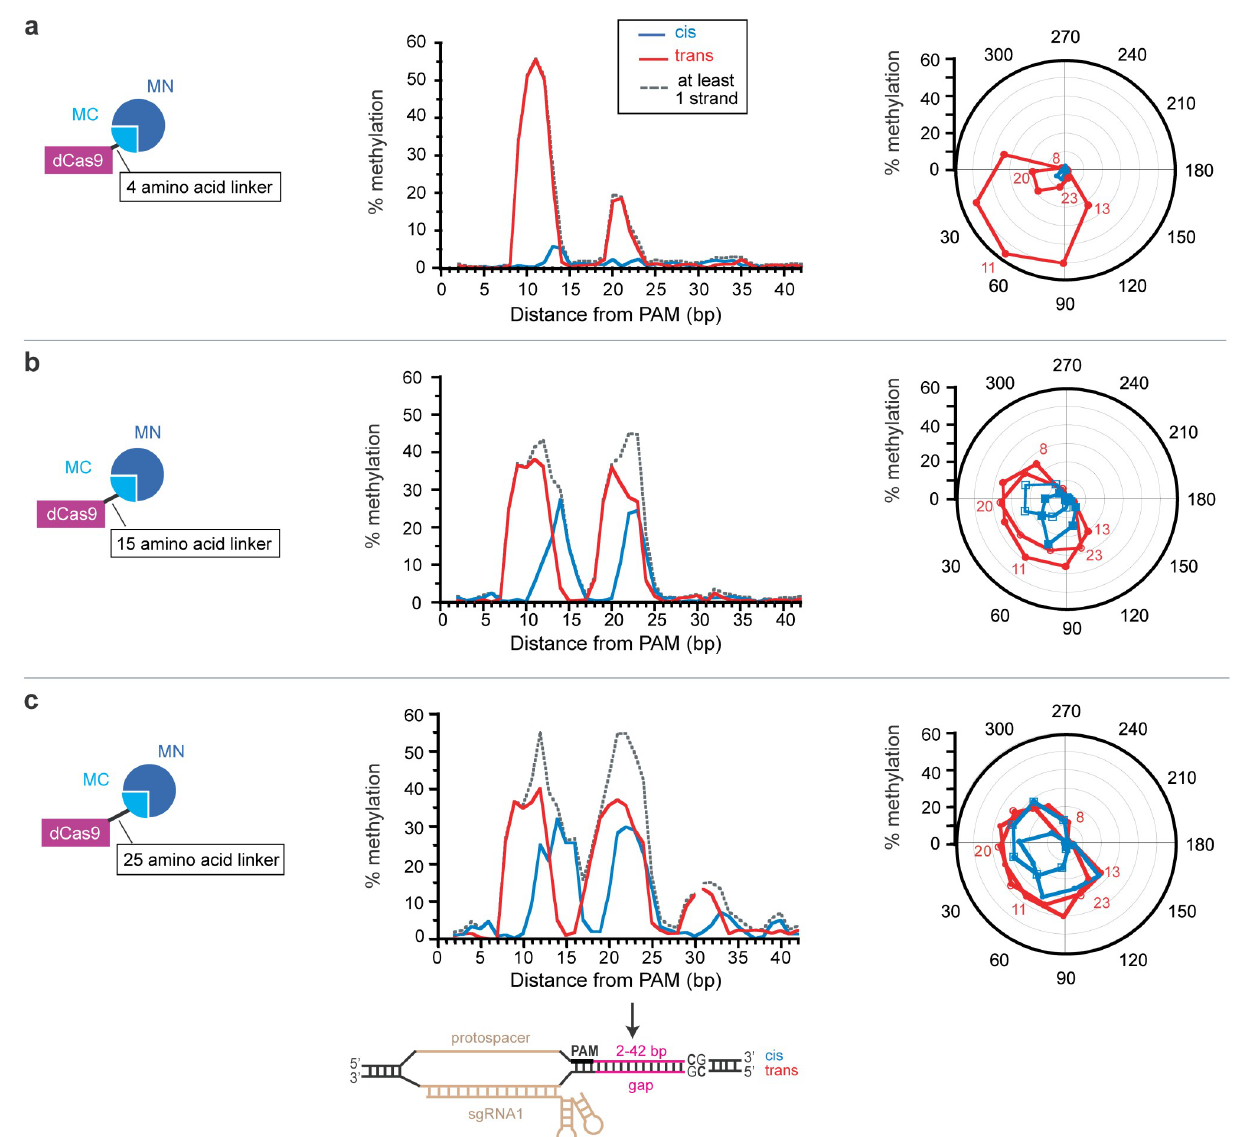
Fig 4. Effect of linker length on methylation in the target region as a function of gap length. Frequency of methylation for cis and trans strand are presented as a function of distance from the PAM (center) and the angle between the dCas9 C-terminus and the MC N-terminus (right) in the structural model for dCas9-MC/MN for a (a) 4-amino acid linker, (b) 15-amino acid linker, or (c) 25-amino acid linker. The angle is defined as that formed between the C-terminus of Cas9 and N-terminus of MC when looking down the DNA axis from the CpG site towards the PAM (i.e. the angle formed in the plane of the page in the view of Fig 2b and 2d). Full amino acid sequences of linkers can be found in Fig 1a. The dotted line indicates the fraction of the target sites that are methylated on at least one strand assuming that cis and trans strand methylation is independent. For c, methylation frequency data was not obtained for the trans strand for the gap lengths of 31 and 37 bp. Data in (b) is from Xiong et al.